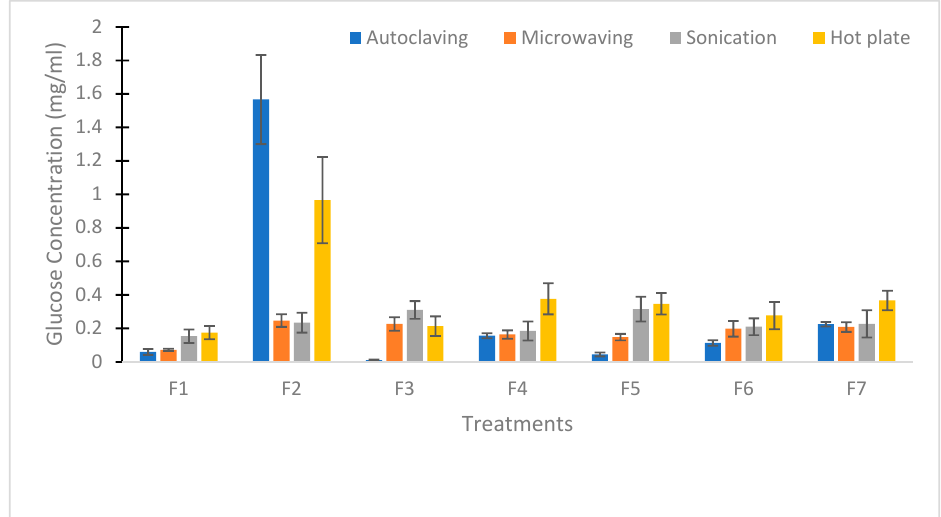
Figure 2. Screening of the optimum combined chemical and physical treatments resulted in the highest production of glucose units from cellulosic fiber wastes. F1, F2, F3, F4, F5, F6, and F7 are the treatments of 1% fiber waste using d.H 2 O, 20% HCl, 20% H 2 SO 4 , 20% H 3 PO 4 , 100% acetic acid, 5M NaOH, and 5M KOH, respectively.